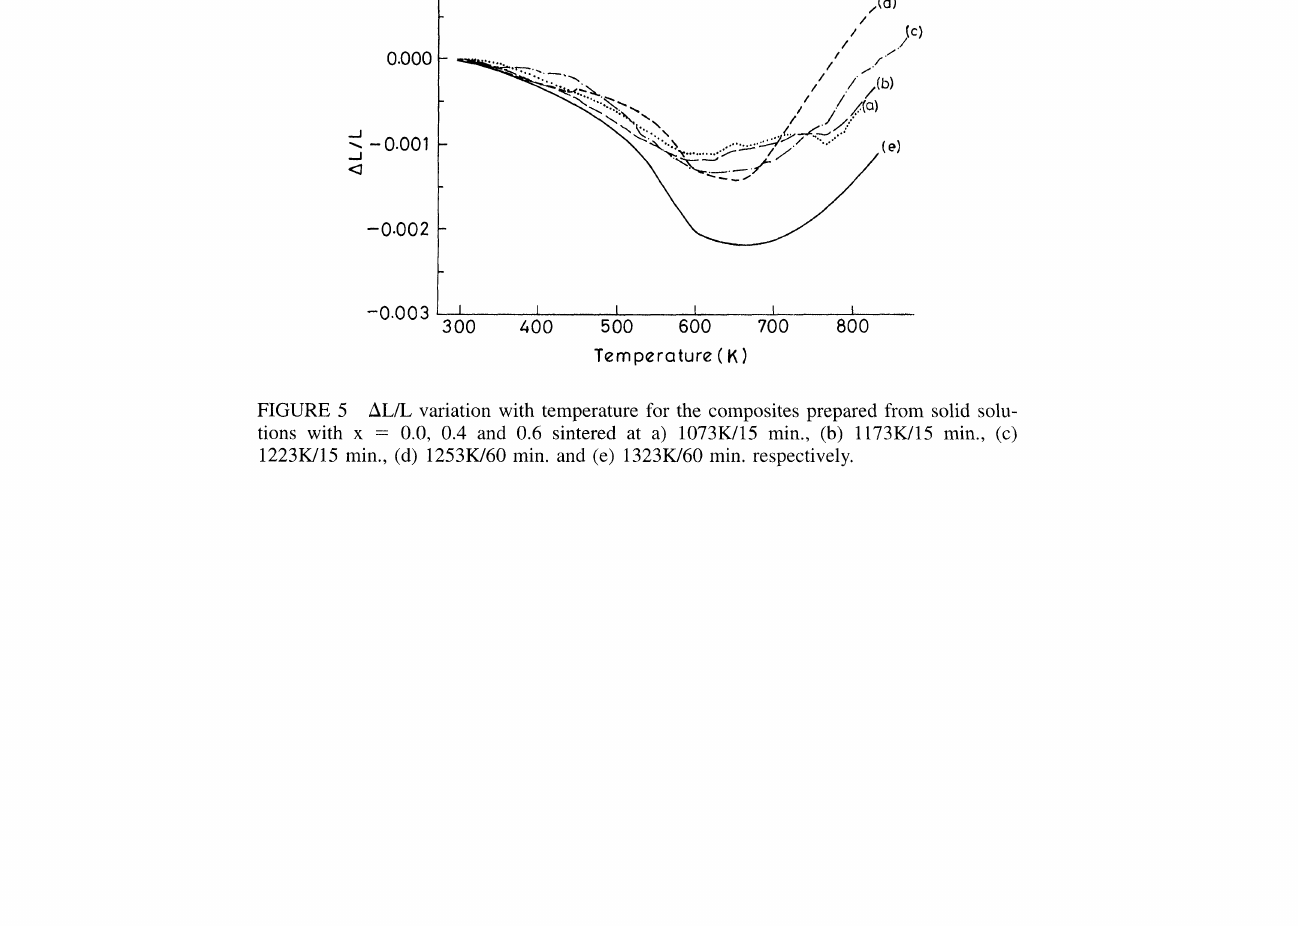
FIGURE 4 Variation of c/a ratio and transition temperature (To) with x in the PFNI_xPT system. Open symbols are for C1-1323 composite.